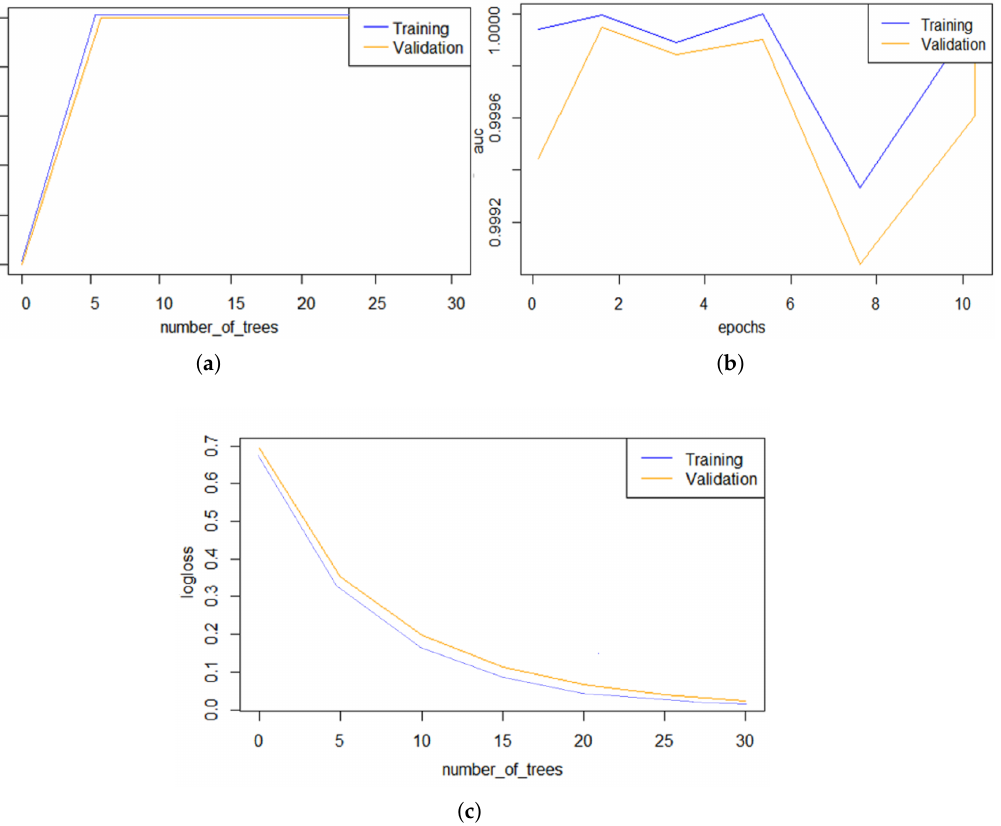
Figure 7. The scoring history results during the model training and testing: ( a ) AUC vs. number of trees; ( b ) AUC vs. number of epochs; ( c ) the cross-entropy or logloss vs. number of trees during the training and validating stages of the proposed